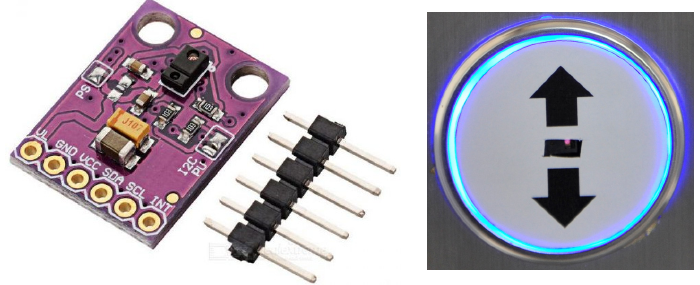
Figure 8. Gesture recognition sensor.